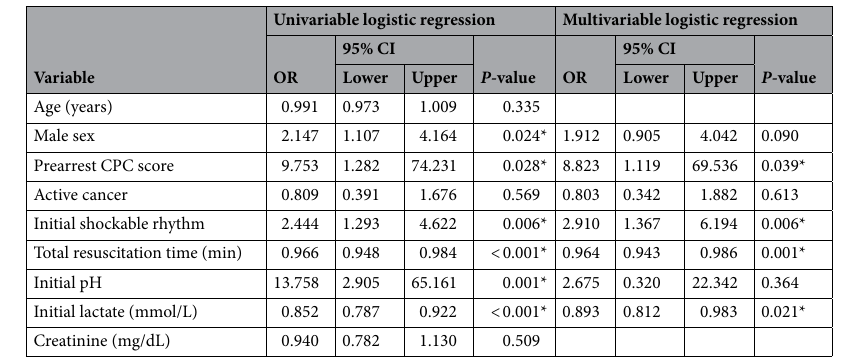
Table 3. Univariable and multivariable logistic regression analyses regarding 6-month good neurologic outcome. *Statistically significant. OR Odds ratio, CI Confidence interval, CPC Cerebral performance category.